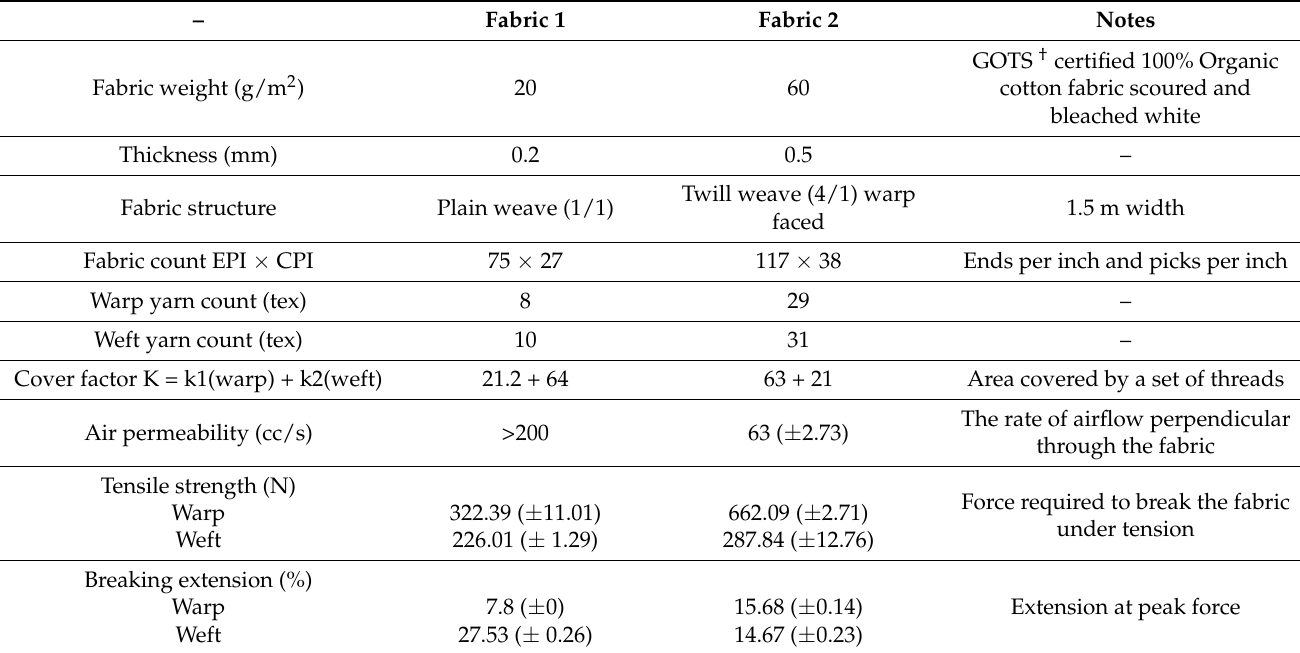
Table 1. Physical properties of